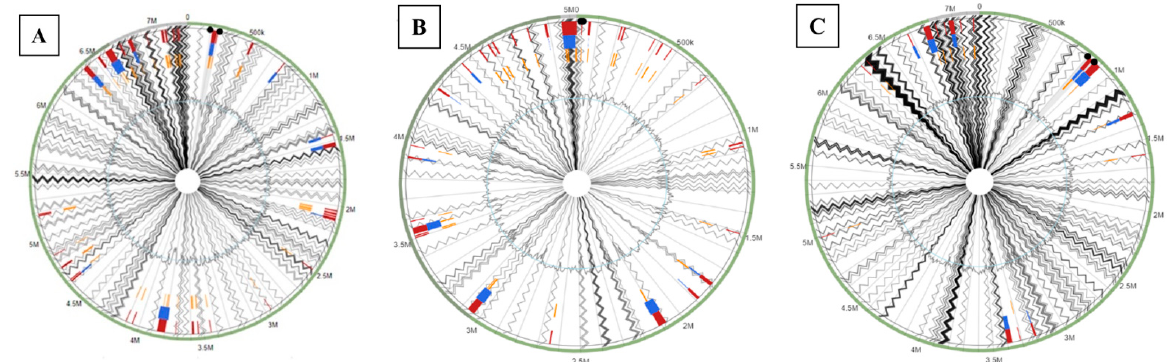
Figure 4. Genomic islands identified within the whole genome sequence of ( A ), Pseudomonas alcaligenes OT69; ( B ), Pseu- domonas stutzeri MF28 and ( C ), Pseudomonas aeruginosa WC55. Reference genomes used in this analysis were as follows: Pseudomonas alcaligenes strain NEB 585 for strain OT69, Pseudomonas stutzeri DSM 10701 for strain MF28 and Pseudomonas aeruginosa PAO1 for strain WC55. The outer black circle represents the scale line in Mbps, and genomic islands (GEIs), obtained from each of the following methods are shown in color: SIGI-HMM (orange), IslandPath-DIMOB (blue), and integrated detection (red),